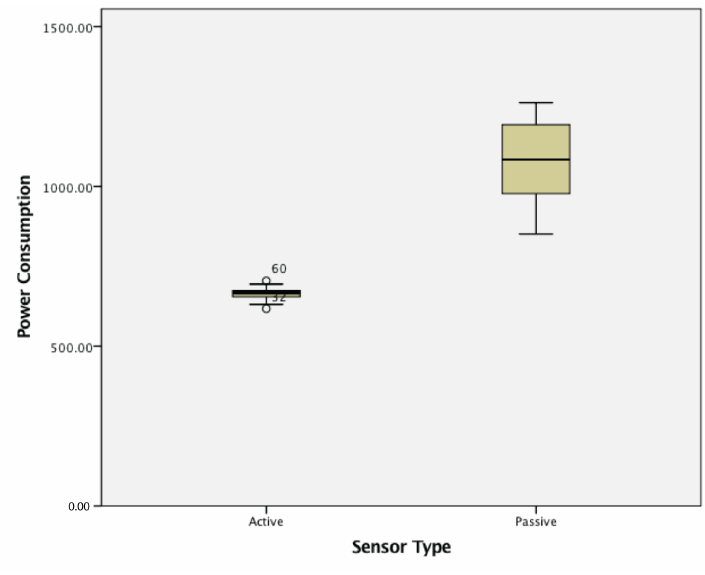
Figure 21. Power consumption in a cluster of active vs. passive wireless sensor